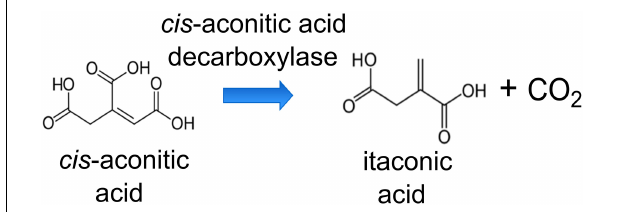
FIGURE 1 | Reaction scheme of the conversion of cis -aconitic acid to itaconic acid (ITA) by cis- aconitic acid decarboxylase (Cad).